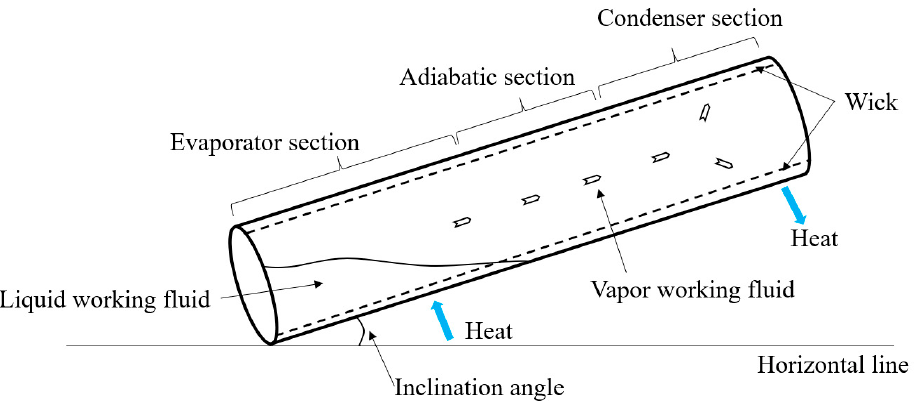
Figure 1. Working process and influencing factors of the isothermal performance of heat pipes.